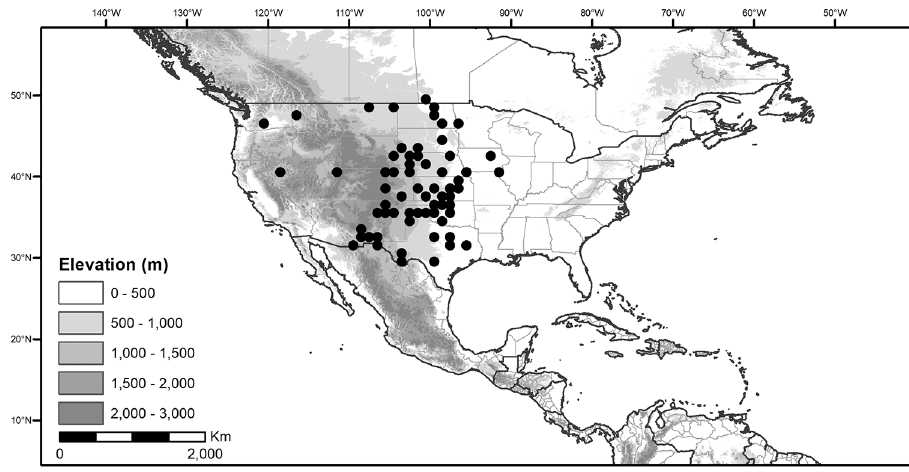
Figure 23. Distribution of Solanum interius